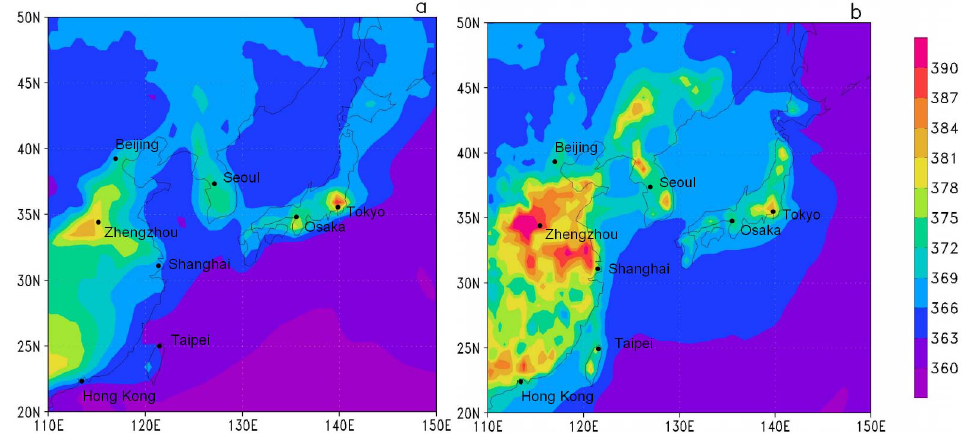
Fig. 13. Simulated surface CO 2 concentrations (ppmv) around Japan at 21:00 UTC on 26 March 2008: (a) NIES-05/VL/0.625, (b) NIES- 05/SLM/0.625.